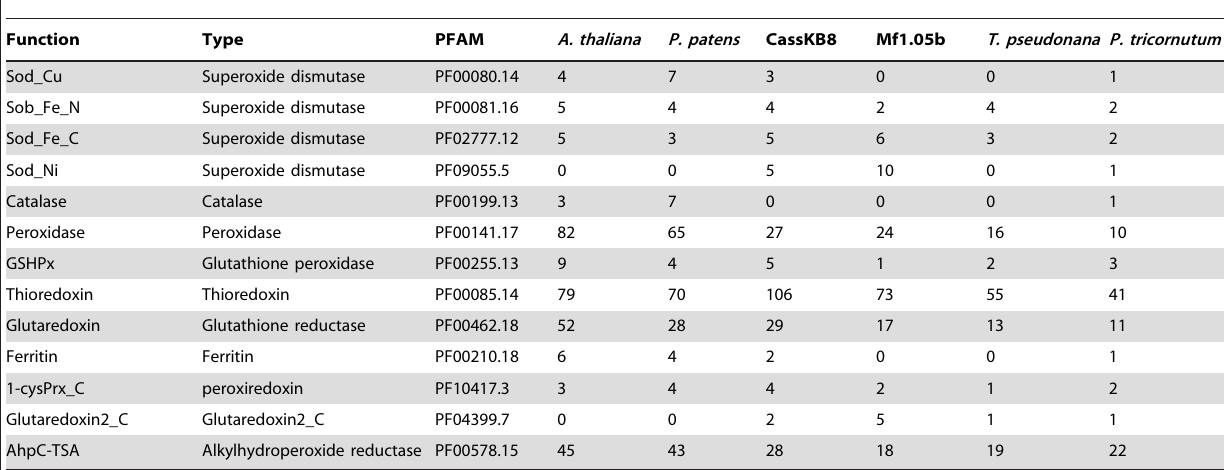
Table 7. Comparison of the antioxidant gene repertoire between Arabidopsis thaliana , Phycomitrella patens , Symbiodinium sp. CassKB8, Symbiodinium sp. Mf1.05b, Thalassosira pseudonana , and Phaeodactylum tricornutum based on Pfam domains associated with antioxidant function.